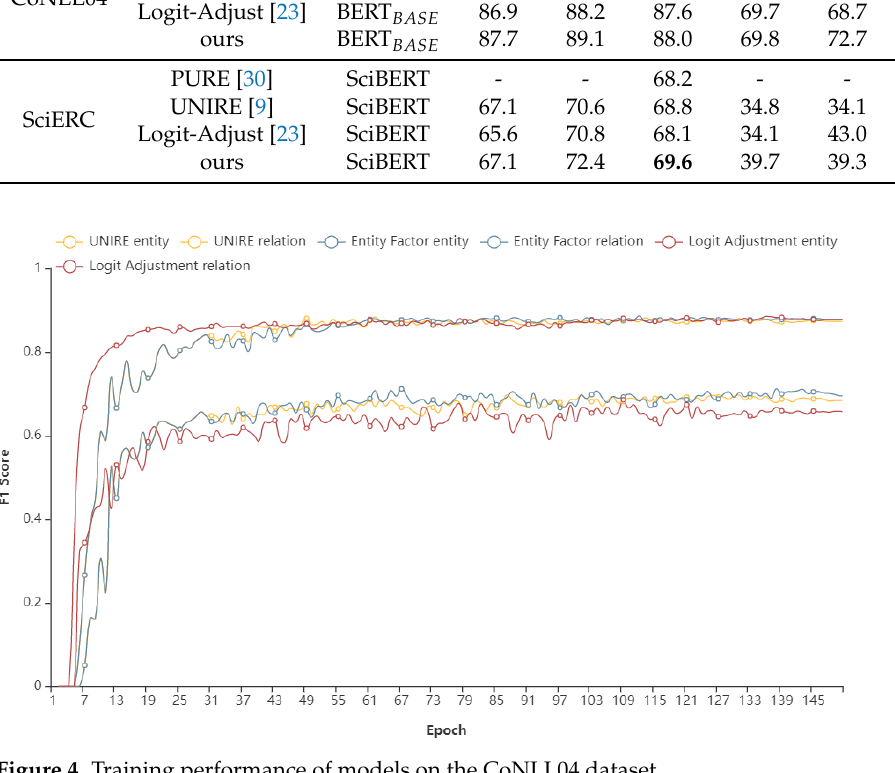
Figure 4. Training performance of models on the CoNLL04